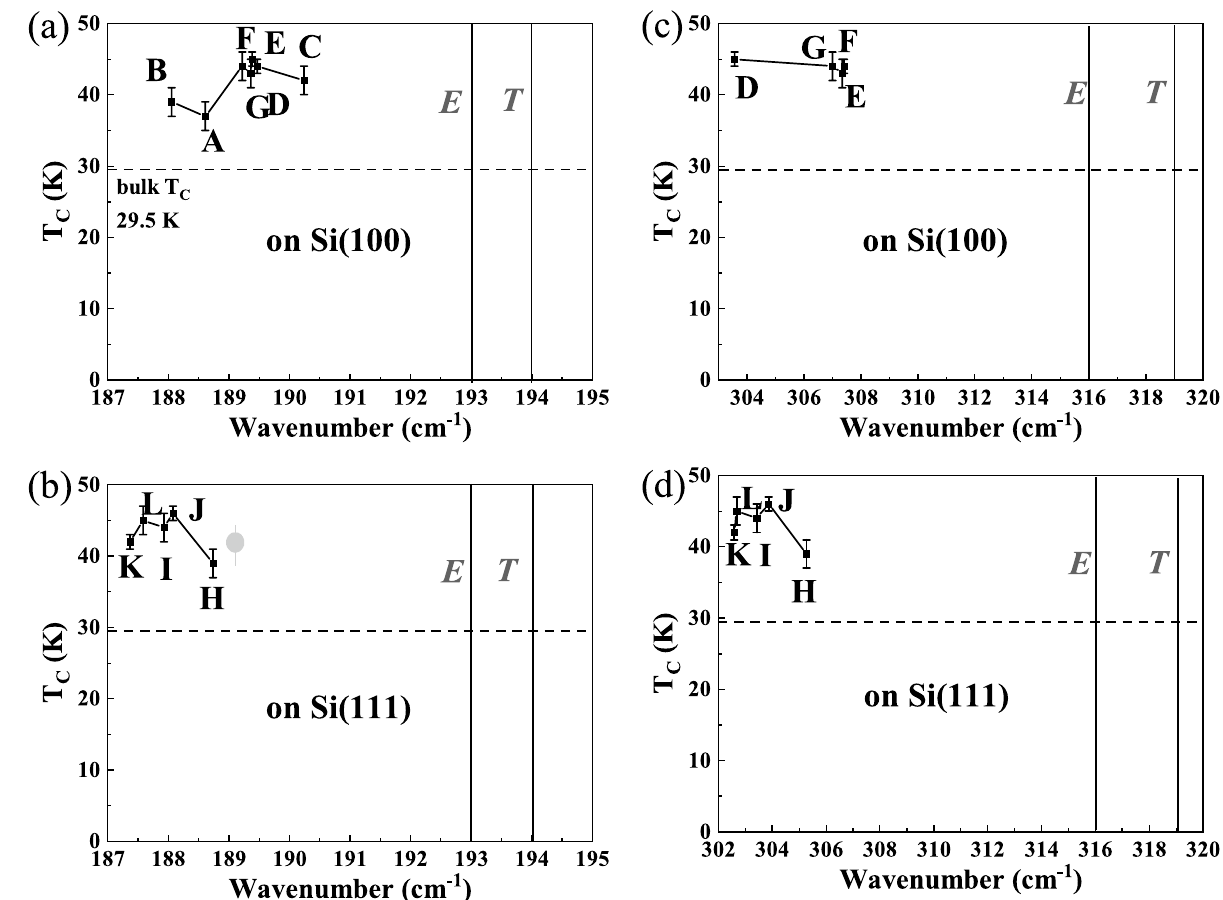
Figure 6. Curie temperature as a function of the Raman shifts of MnSi films. ( a , b ) for the Raman mode around 188 cm −1 . ( c , d ) for the Raman mode around 303 cm −1 . All samples have approximately the same Curie temperature and show no dependence on the Raman shift. The sample ID is indicated in the figures around the corresponding data point. In panel ( c ) the data point indicated by a grey solid circle is from Ref. 41 . The dashed horizontal lines labels the Curie temperature of 29.5 K for bulk MnSi. The vertical solids labels the Raman modes for bulk